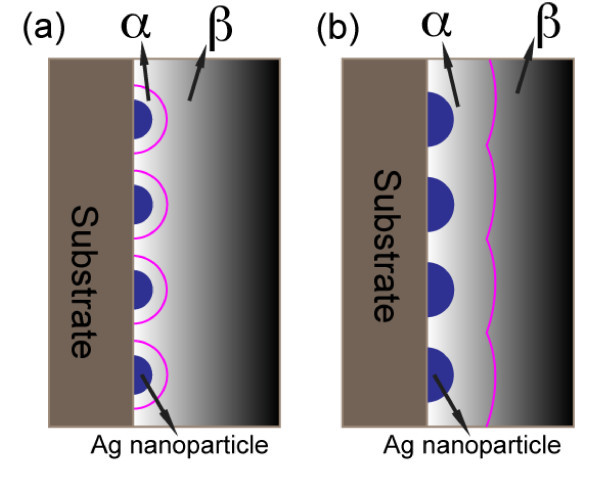
Different ion concentrations cause interparticle interaction transition. (a) Weak interaction at higher concentration (thinner depletion layer), (b) strong interparticle interaction at lower concentration (thicker depletion layer). α is the depletion layer and β is the diffusion layer. The purple lines indicate the interface between diffusion layer and depletion layers.